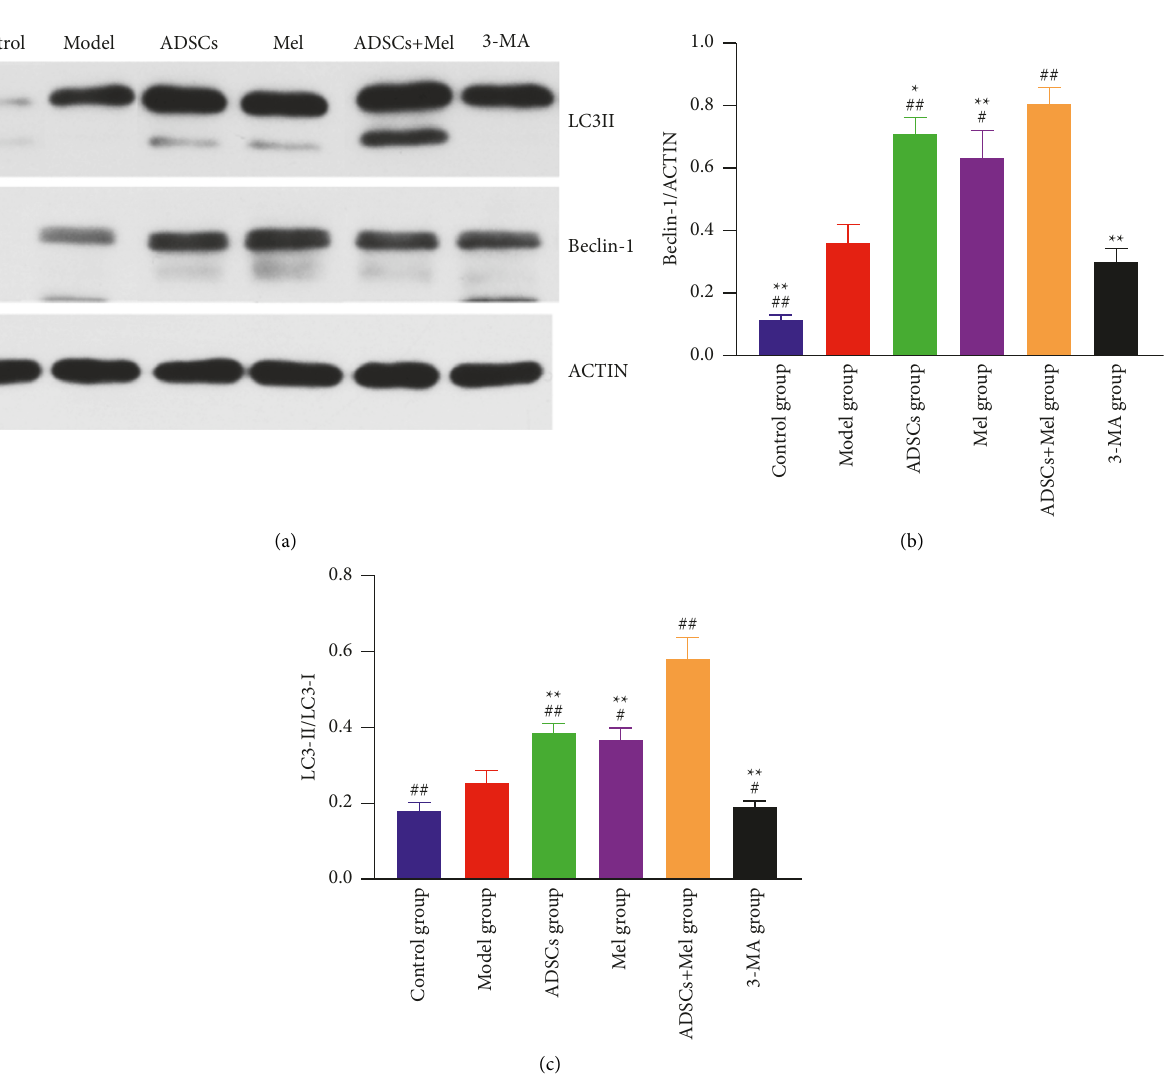
Figure 6: Expression of LC3 and Beclin-1 in rat sciatic nerve. (a) Western blot image of autophagy-related proteins LC3 and Beclin-1. (b) Beclin-1/ACTIN statistics. (c) LC3-II/LC3-I statistics. The control group, ADSCs group, Mel group, ADSCs+Mel group, and 3-MA group were compared with the model group, respectively. Each value is the mean ± SE of four independent determinations. ## P < 0 . 01, # p < 0 . 05 compared with the model group; ∗∗ p < 0 . 05, the control group, ADSCs group, model group, Mel group, ADSCs+Mel group, and 3-MA group were compared with the ADSCs+Mel